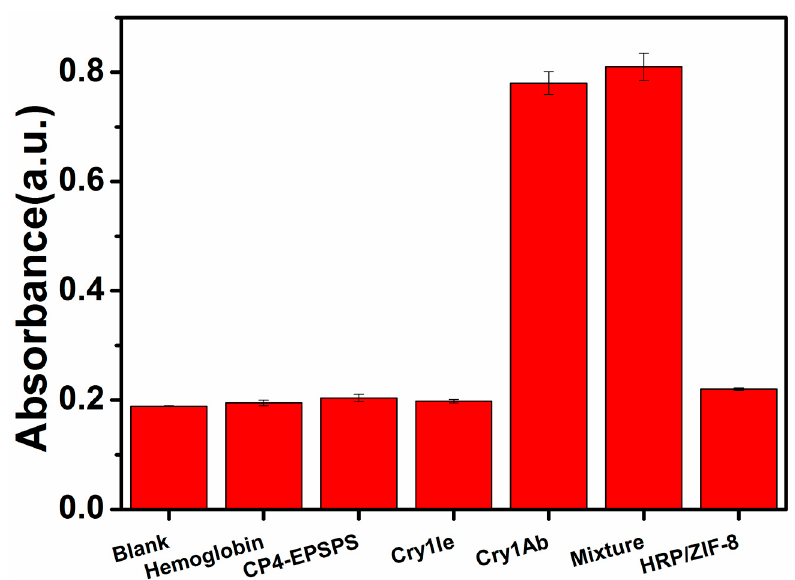
Figure 4. Selectivity of the proposed method. Table 2. Recoveries of Cry1Ab.